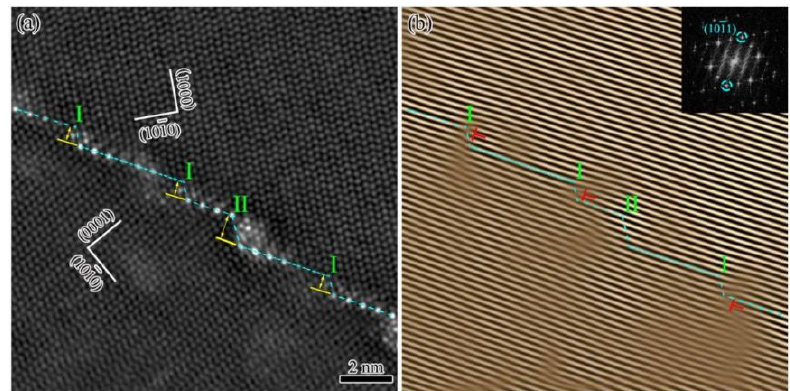
Figure 2. TEM images of {101 ̅ 1} twin boundary in [12 ̅ 10] zone axis: ( a ) an atomic-scale HAADF-STEM image with micro-steps; and ( b ) a lattice fringes images obtained by the inverse Fourier transform (IFFT) of (101 ̅ 1) diffraction spots of the HAADF-STEM image and the Fourier transform diffraction pattern.